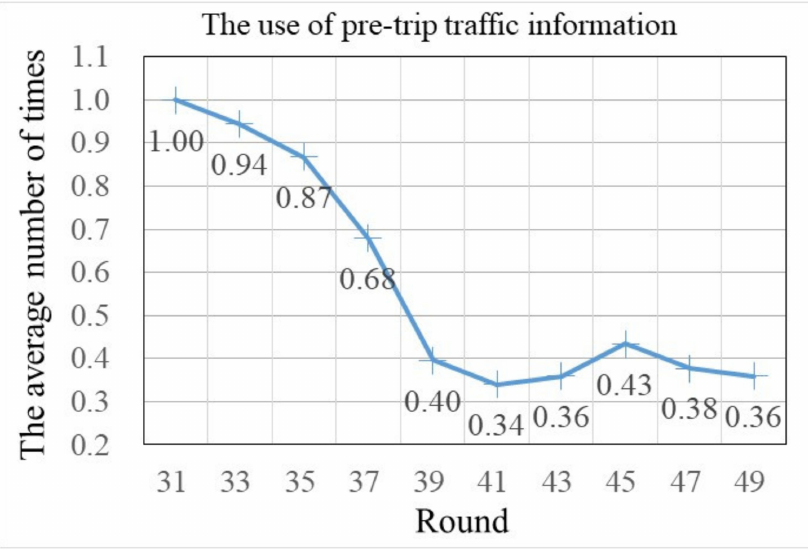
Figure 7. The average number of times the pre-trip traffic information was used in rounds 31–50.